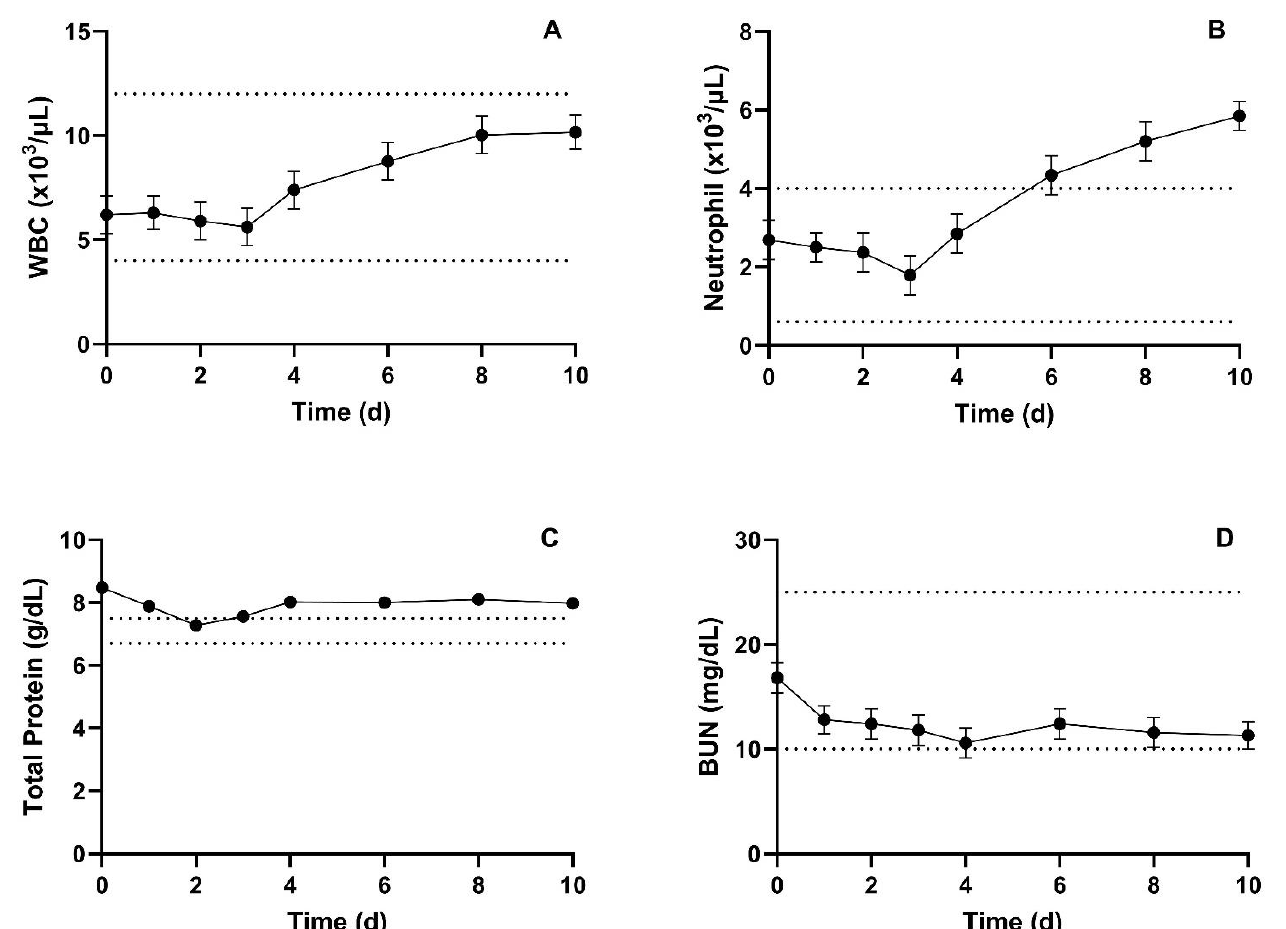
Figure 4. Summary mean ( ± SEM) WBC counts ( A ), Neutrophil counts ( B ), total protein ( C ), and BUN ( D ) prior to, and for 10 days following, administration of 30 mg/kg meloxicam. Dotted lines denote provided upper and lower reference